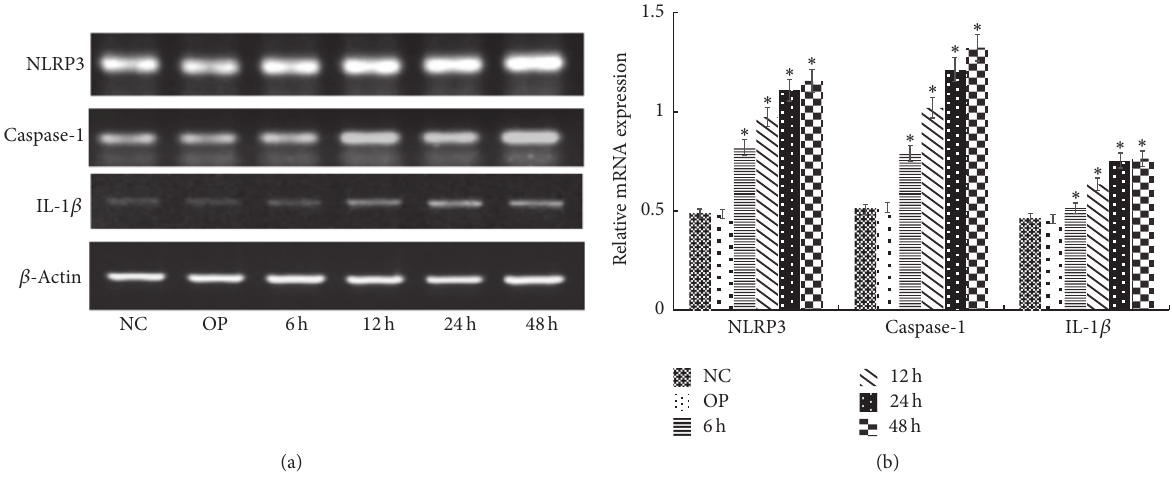
Figure 1: The mRNA expression of NLRP3, caspase-1, and IL-1 𝛽 in mesangial cells treated with 30 mmol/L glucose for different time. (a) RT-PCR strip chart for different time. NLRP3, caspase-1, and IL-1 𝛽 mRNA increased significantly after 6h, 12 h, 24 h, and 48 h of exposure to 30 mmol/L glucose. (b) The corresponding relative gray value statistics graph of the mRNA level. ∗ 𝑃 < 0.05 versus NC